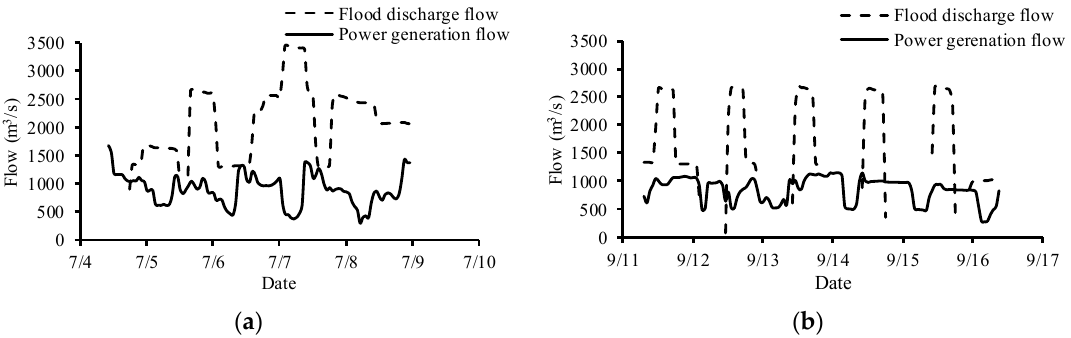
Figure 3. Flow discharge from the Dagangshan hydropower station in July ( a ) and September ( b ).